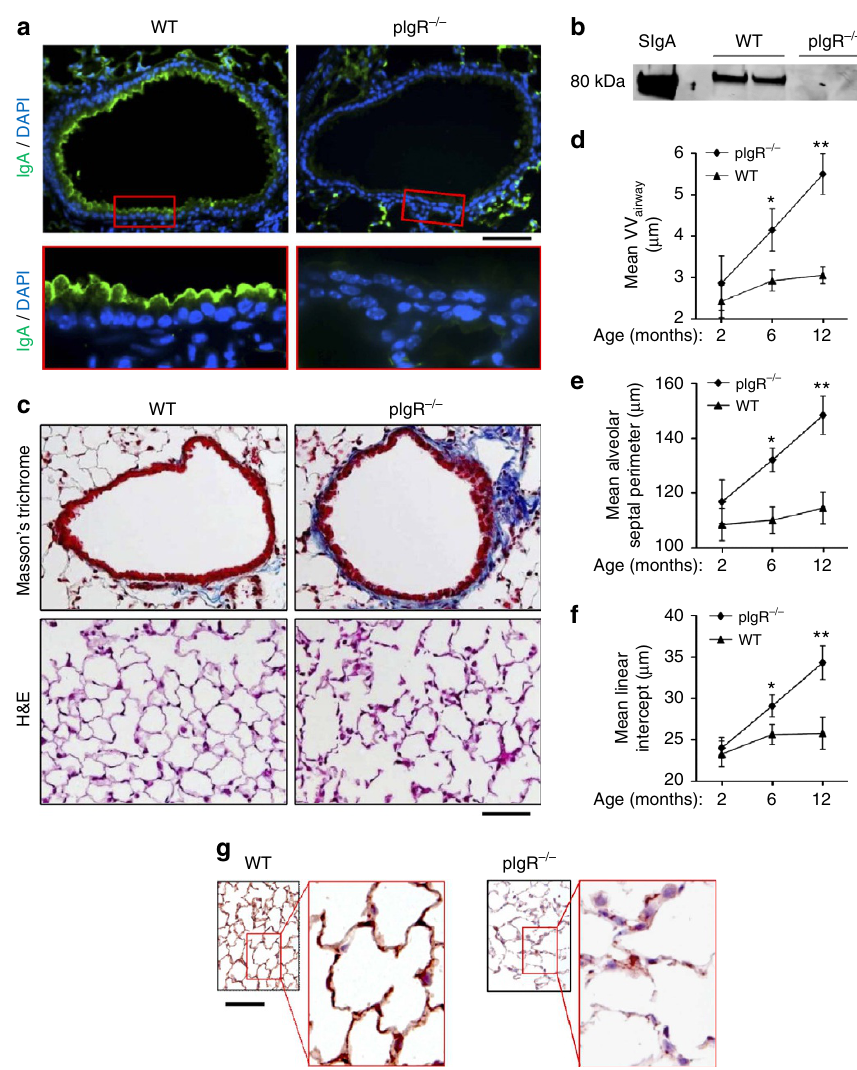
Figure 1 | pIgR (cid:2) / (cid:2) mice develop progressive COPD-like small airway and parenchymal remodelling. ( a ) Immunofluorescence staining for IgA (green) showing SIgA on the epithelial surface of a small airway from a WT mouse and no detectable SIgA on the airway surface of a pIgR (cid:2) / (cid:2) mouse (original magnification, (cid:3) 200 and (cid:3) 1,000 (insets)). Scale bar, 50 m m. ( b ) Western blotting for secretory component in BAL fluid from WTand pIgR (cid:2) / (cid:2) mice. SIgA from human colostrum was used as a positive control. ( c ) Representative images of small airway remodelling (Masson’s trichrome, original magnification, (cid:3) 200) and emphysema (haematoxylin and eosin (H&E), original magnification, (cid:3) 200) in a 12-month-old pIgR (cid:2) / (cid:2) mouse compared with a WT control. Scale bar, 50 m m. ( d – f ) Morphometric analysis showing increased wall thickness (VV airway ), mean alveolar septal perimeter length and mean linear intercept in pIgR (cid:2) / (cid:2) and age-matched WT littermate controls at the indicated ages. Five to ten mice per group; * P o 0.01 compared with 2-month-old pIgR (cid:2) / (cid:2) mice and age-matched WT controls; ** P o 0.001 compared with all other groups (two-way analysis of variance (ANOVA)). ( g ) Immunostaining for elastin in 12-month-old WTand pIgR (cid:2) / (cid:2) mice shows reduction and fragmentation of elastin in inter-alveolar septa in a pIgR (cid:2) / (cid:2) mouse compared with the intact elastin network in a WT mouse (original magnification, (cid:3) 100 and (cid:3) 1,000